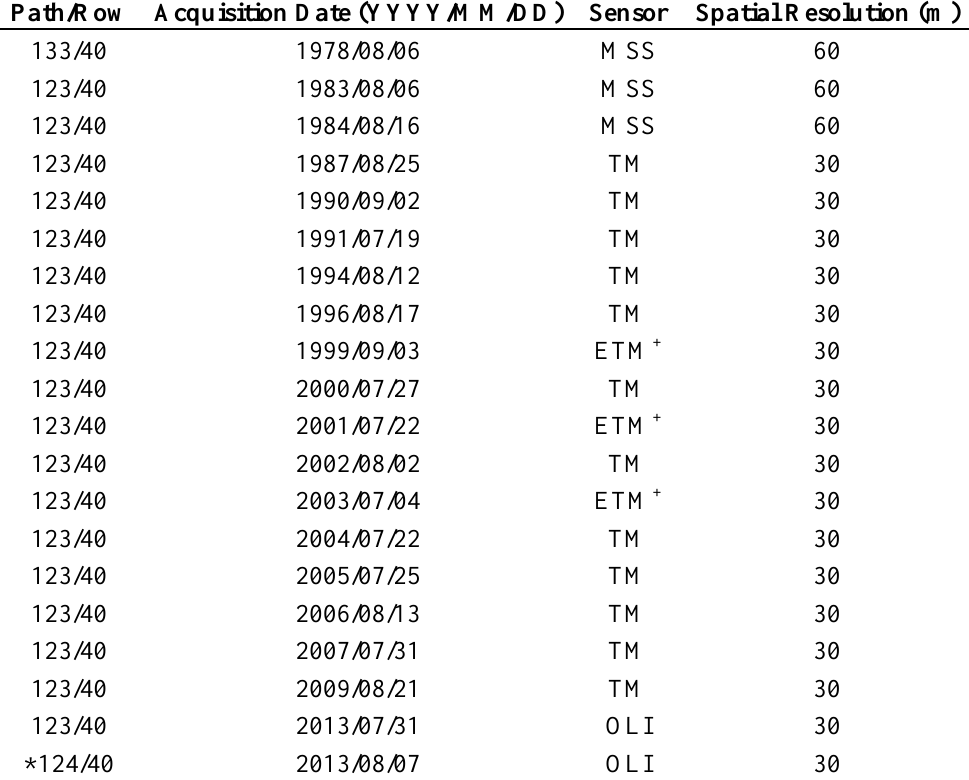
Table 1. Landsat satellite images used in the study. Note that images were acquired between July and September of each